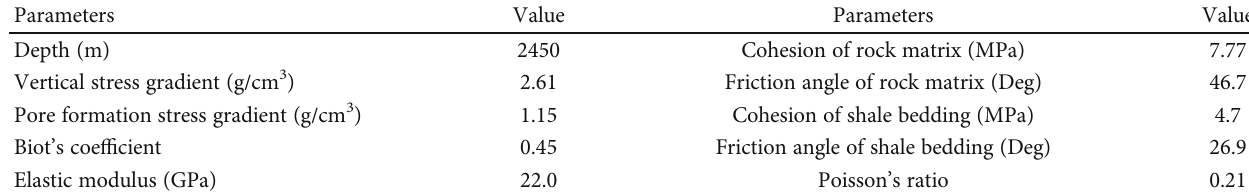
Table 2: Mechanical parameters of stratigraphic foundation of the Longmaxi formation.